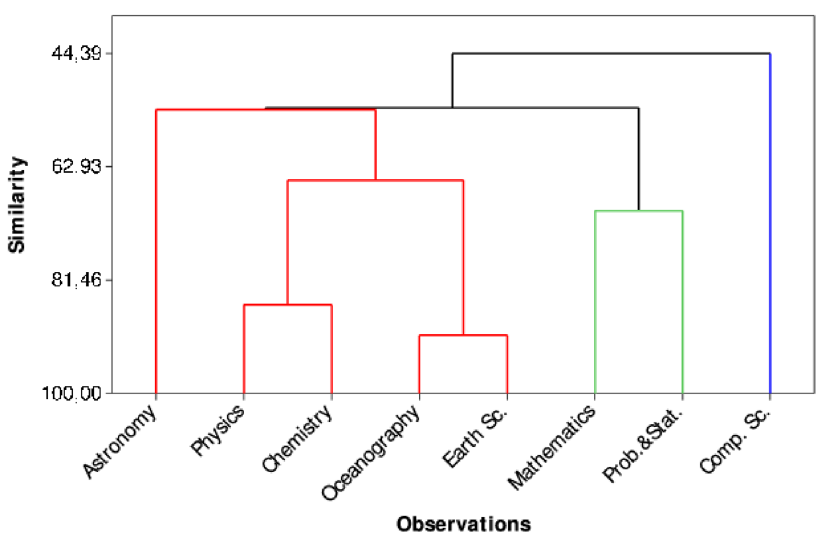
Fig 6. Dendrogram displaying the decline of the Kulczynski index until the 5th